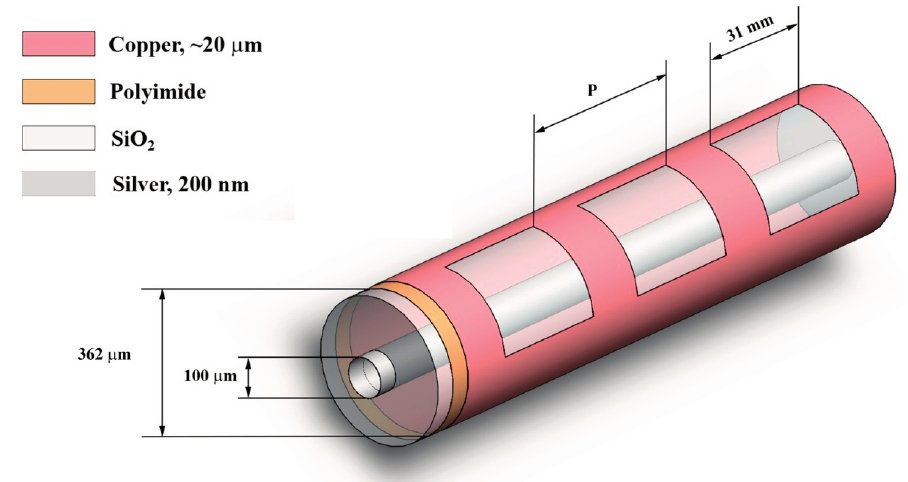
Figure 3. Schematic and radii of the fabricated 3-slit LCXs using hollow-core polymer-clad silica fibers and operating at 2.4 GHz. A 20 μ m layer of protective acrylic coating was deposited over the fiber except for two 2 mm endpoints to allow for electrical